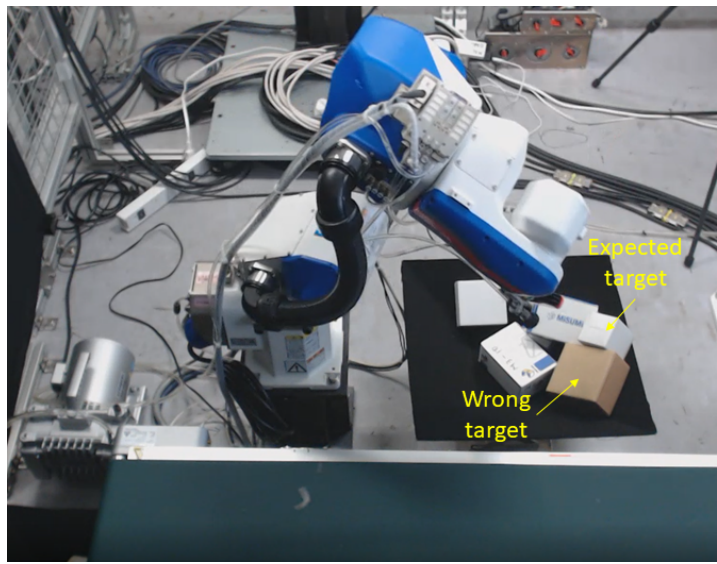
Figure 11. Grasp failure